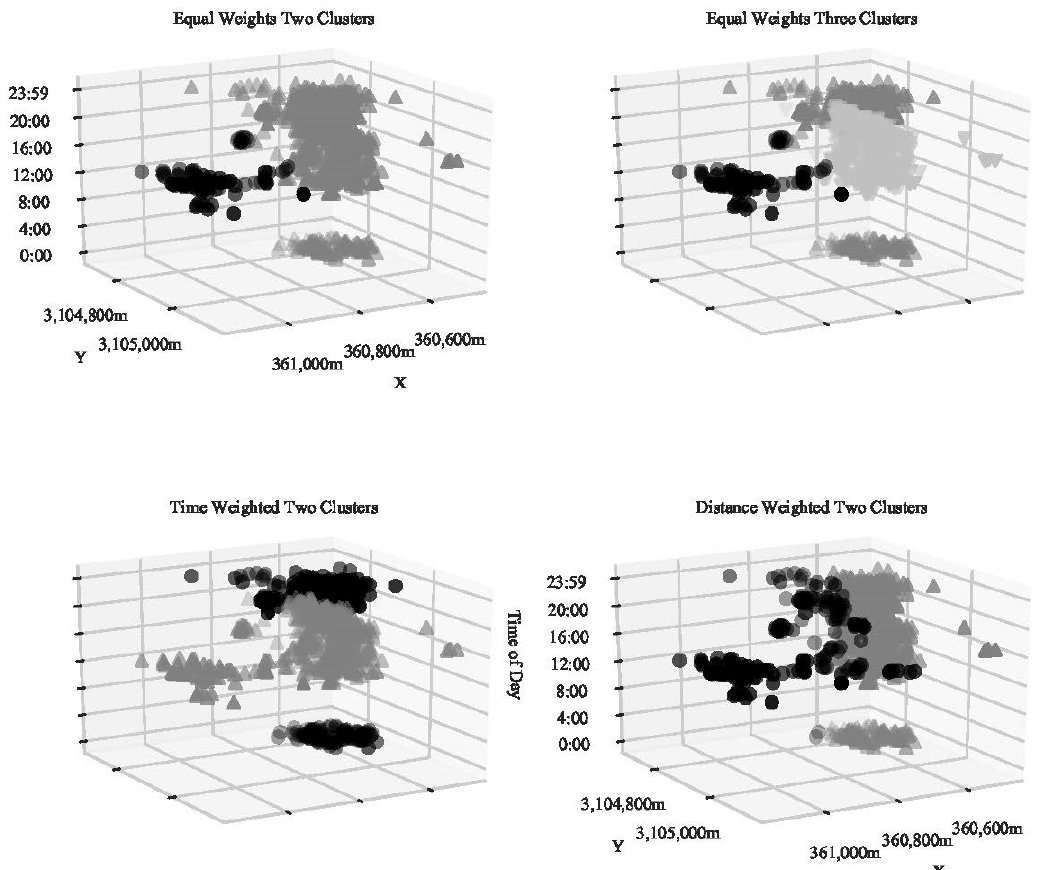
Figure 6. Applied Space-Time Hierarchical Clustering to clustering of GPS observations of a Muscovy Duck.